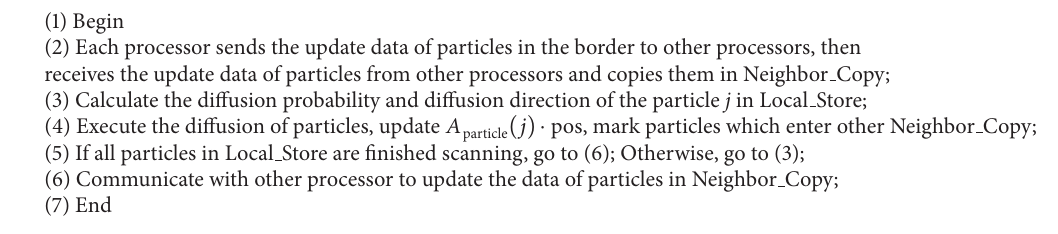
Algorithm 4: The diffusion simulation algorithm of dust particles.